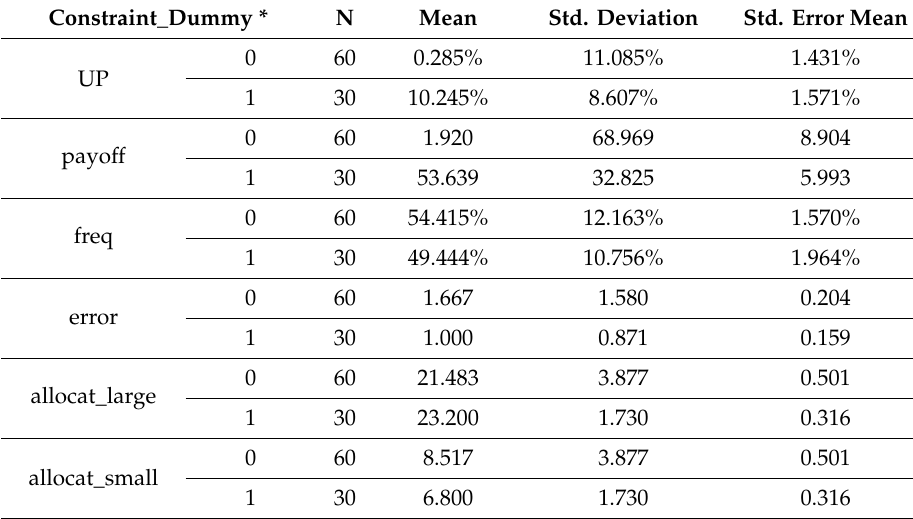
Table 8. Outcomes of the auctions with the highest capacity constraint and other auctions.